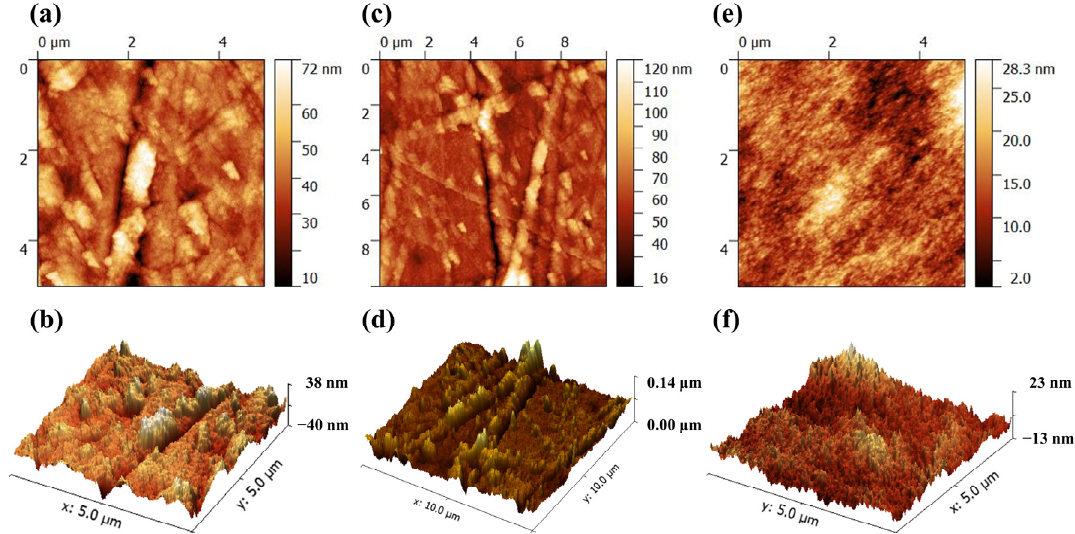
Figure 6. Atomic force microscopy (AFM) images of ( a – d ) composite TN-0.769 and ( e , f ) TN-0.000.